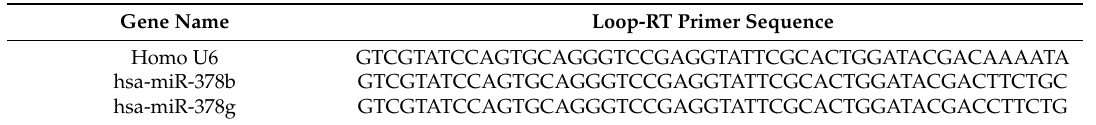
Table 1. List of microRNA reverse transcriptional stem-loop primer sequences.